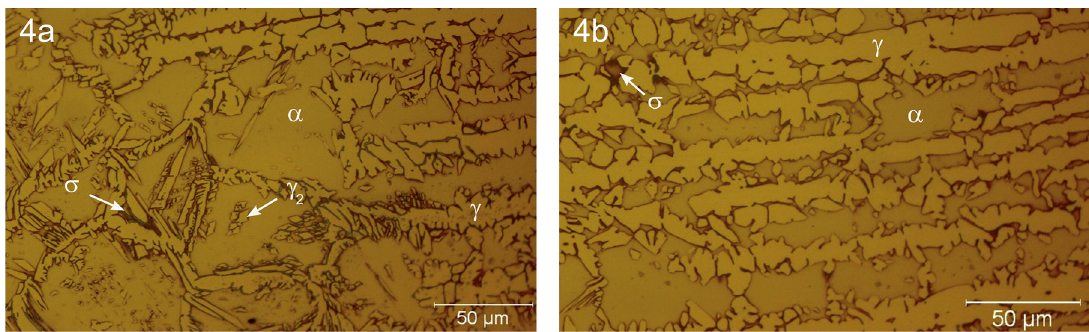
Figure 4. Microstructure of the heat affected zone corresponding to the root pass: a) austenite, ferrite, sigma phase and secondary austenite; b) austenite, ferrite and sigma phase.